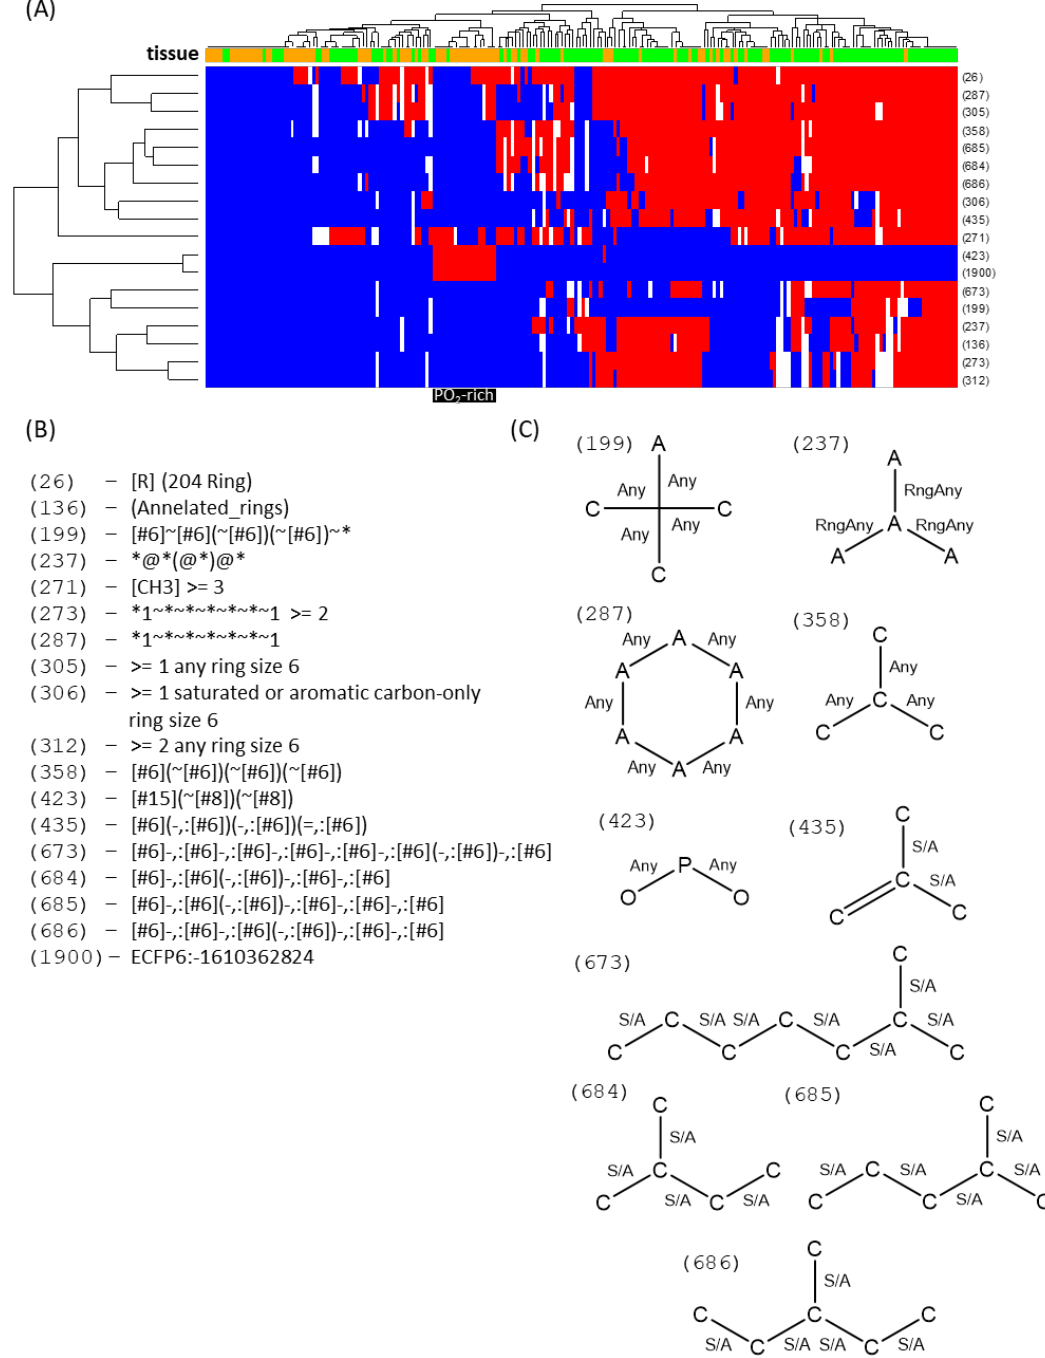
Figure 5. Fingerprint heatmaps of non-polar DAFs. A heatmap ( A ) is shown of the DAFs (columns) that had a fingerprint vector assigned, colored by tissue (green: leaf; orange: pitcher) on the top band. Only the enriched fingerprints (rows) are shown, named by CSI-FingerID relative index position ( A ). Based on posterior probabilities, the fingerprints were determined to be absent (blue), present (red), or uncertain (white). A cluster of DAFs almost exclusively accumulated in pitchers is highlighted in black, with the enriched fingerprints being described in ( B ) and, if graphical representation is possible, in ( C ). Any means it can be any kind of bond, RngAny means the bond is in a ring (of any kind), S/A means it is a single bond that can be anywhere (within a ring or not).